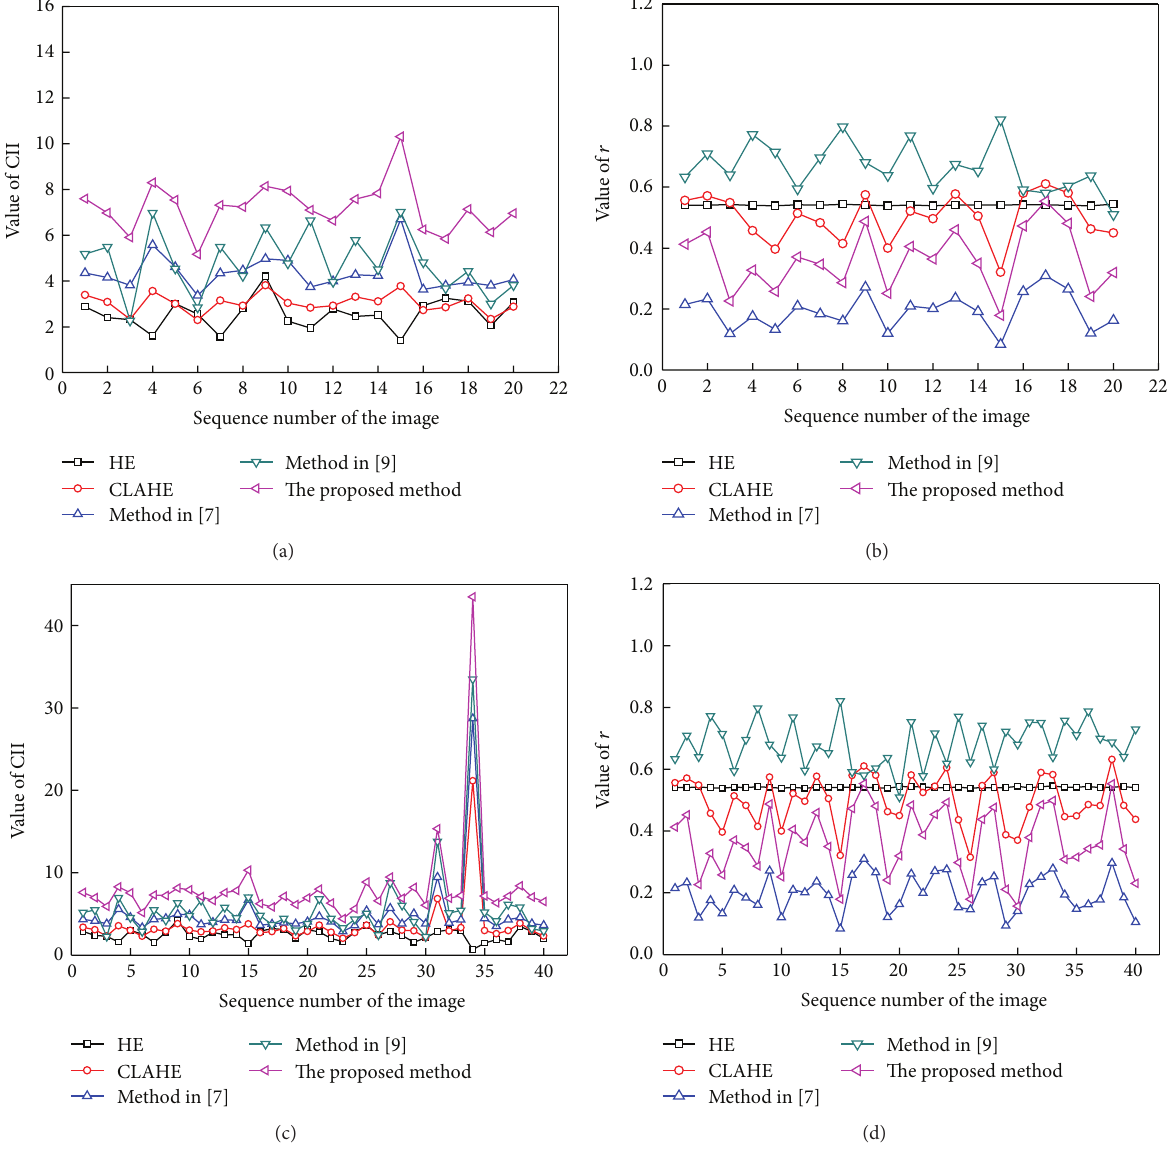
Figure 10: Comparison of the line charts of CII and r on the DRIVE database. (a) The line charts of CII of the testing set; (b) the line charts of 𝑟 of the testing set; (c) the line charts of CII of the testing and training sets; (d) the line charts of r of the testing and training sets.